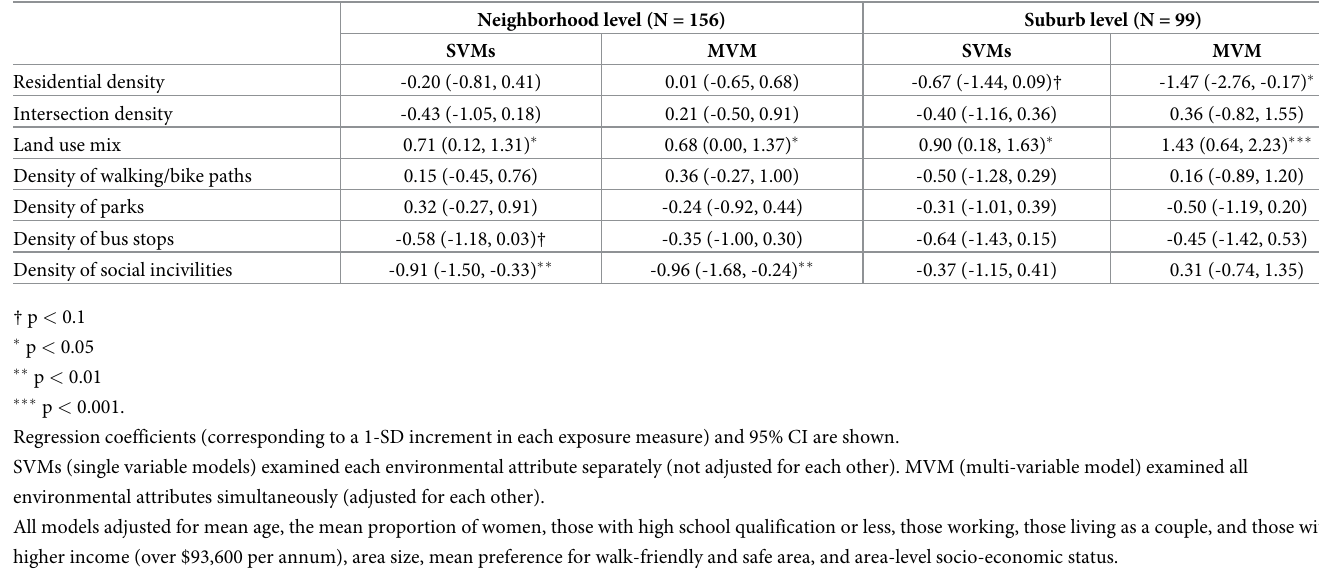
Table 3. Ecological associations of walking mobility score change with environmental